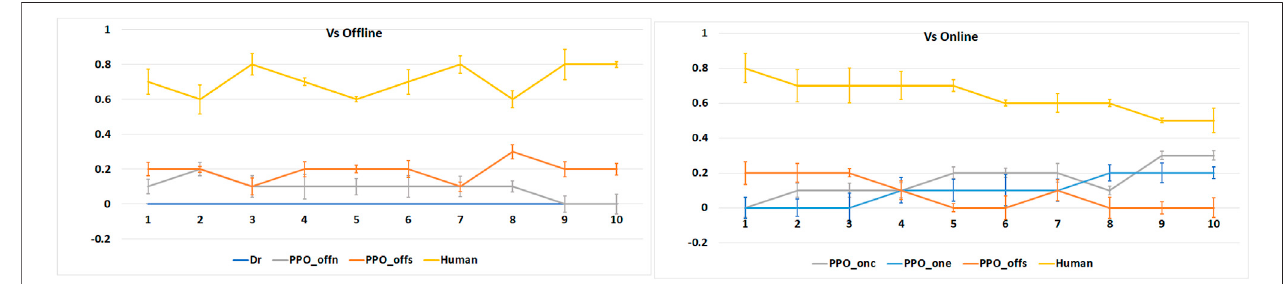
FIGURE 8 | Average number of victories (Y-axis), for 10 human players, per agent type when playing 10 games in a row (X-axis).